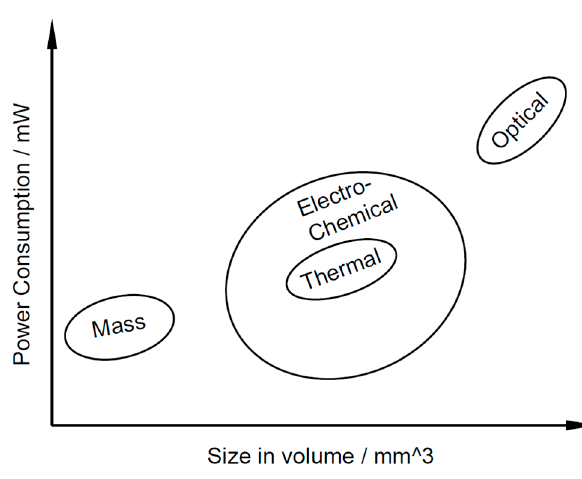
Figure 1. Comparison of the size and power consumption of the four types of gas sensors. Table 1. Specifications of commercial metal oxide (MOX) gas sensor products.